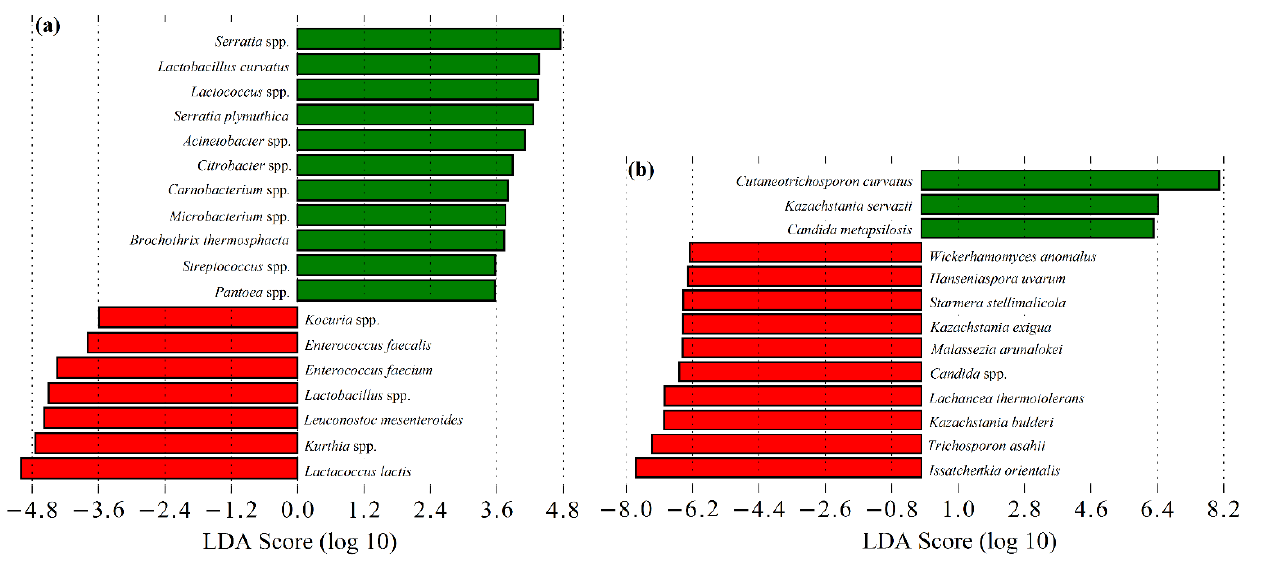
Figure 6. Linear Discriminant Analysis (LDA) scores computed for: ( a ) bacterial and ( b ) fungi features differentially abundant in Serra da Estrela cheese from: ( a ) 2018/2019 (red); ( b ) 2019/2020 (green) campaigns.